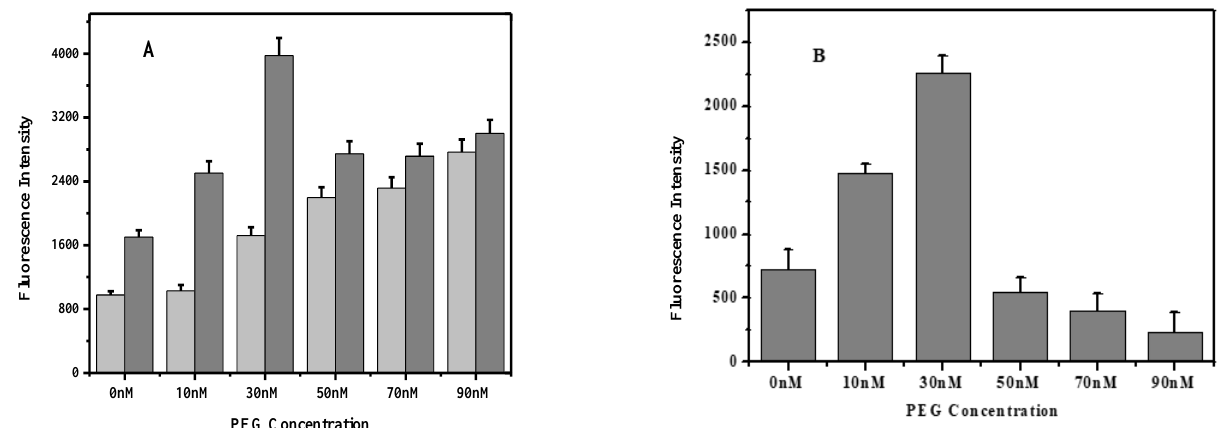
Figure 3. ( A ) Effect of PEG concentrations on the GO-DNA sensor for fluorescence intensity (aptamer adsorpted on the surface of GO without (gray bar) and with (dark grey bar) thrombin); ( B ) effect of PEG concentrations on the GO-DNA sensor for change of fluorescence intensity. The number of samples was 5.